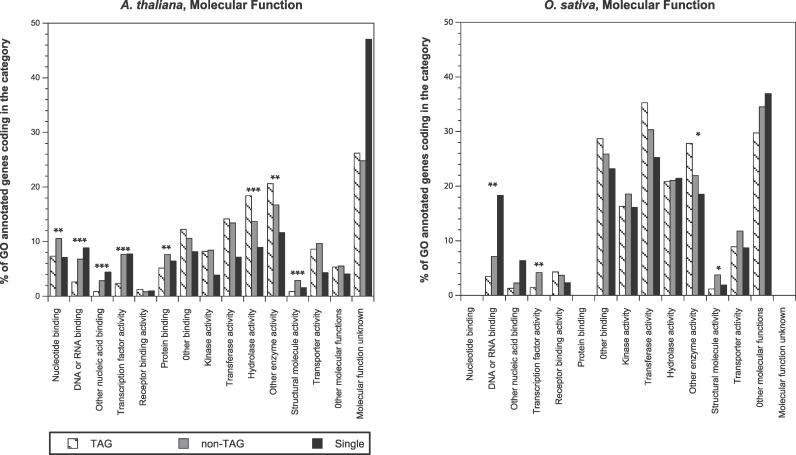
Frequency of Genes in the GO MF categories in Arabidopsis and Rice, Based on the H/0 DatasetOnly the H/0 datasets are shown.The asterisks above the bars indicate significance of the χ2 tests, under the null hypothesis that TAGs and duplicated non-TAG genes have the same proportion.*, p < 0.05; **, p > 0.01; ***, p < 0.001. Bonferonni-corrected for 92 tests.